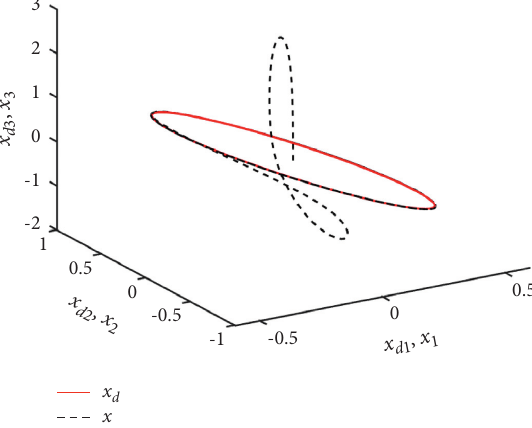
Figure 8: Convergence behavior ( x ⟶ x